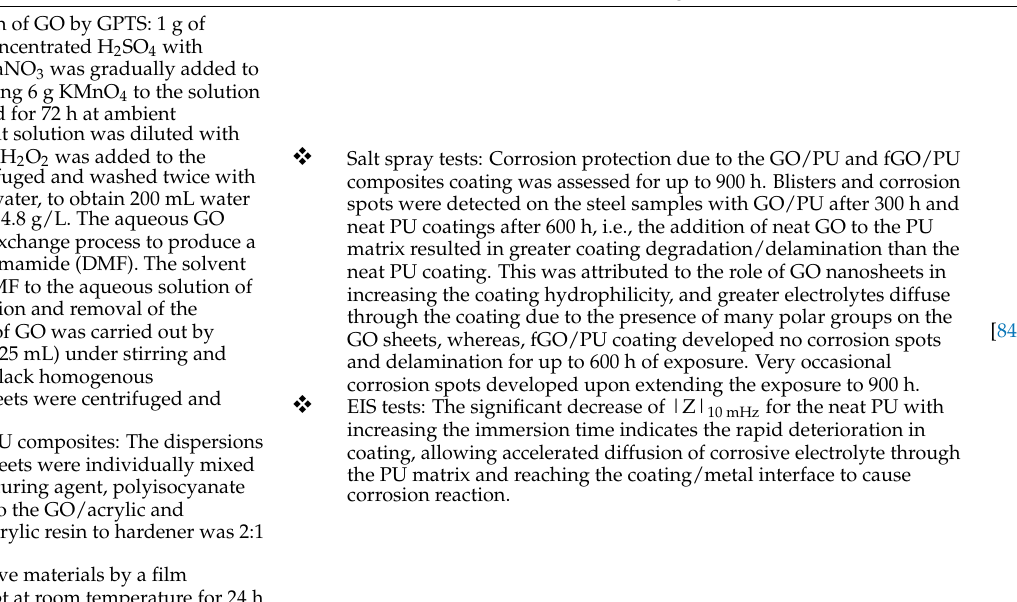
Table 1. Different approaches for improving silane coatings and the main findings, as reported in the literature. Silane(s) Used Coating Preparation Main Findings Ref.